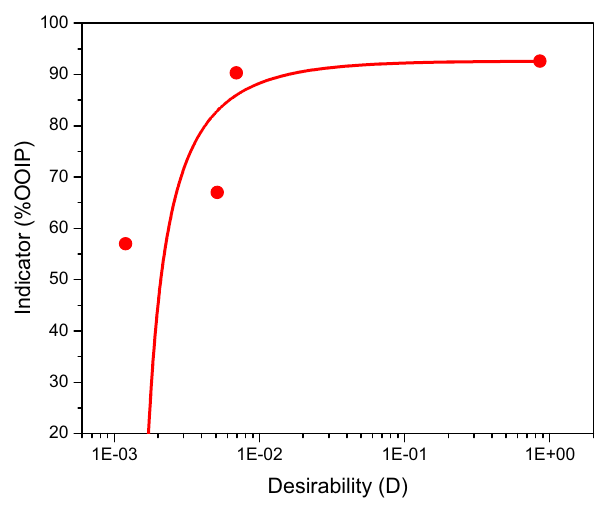
Fig. 3 Desirability ( D ) combined from three affecting factors to the oil recovery (%OOIP) as an assessing indicator. The line is nonlinear curve fit with R 2 =